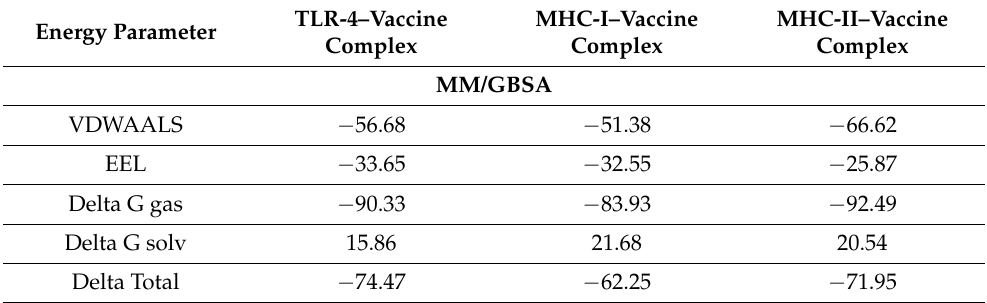
Table 14. Binding free energies calculations.